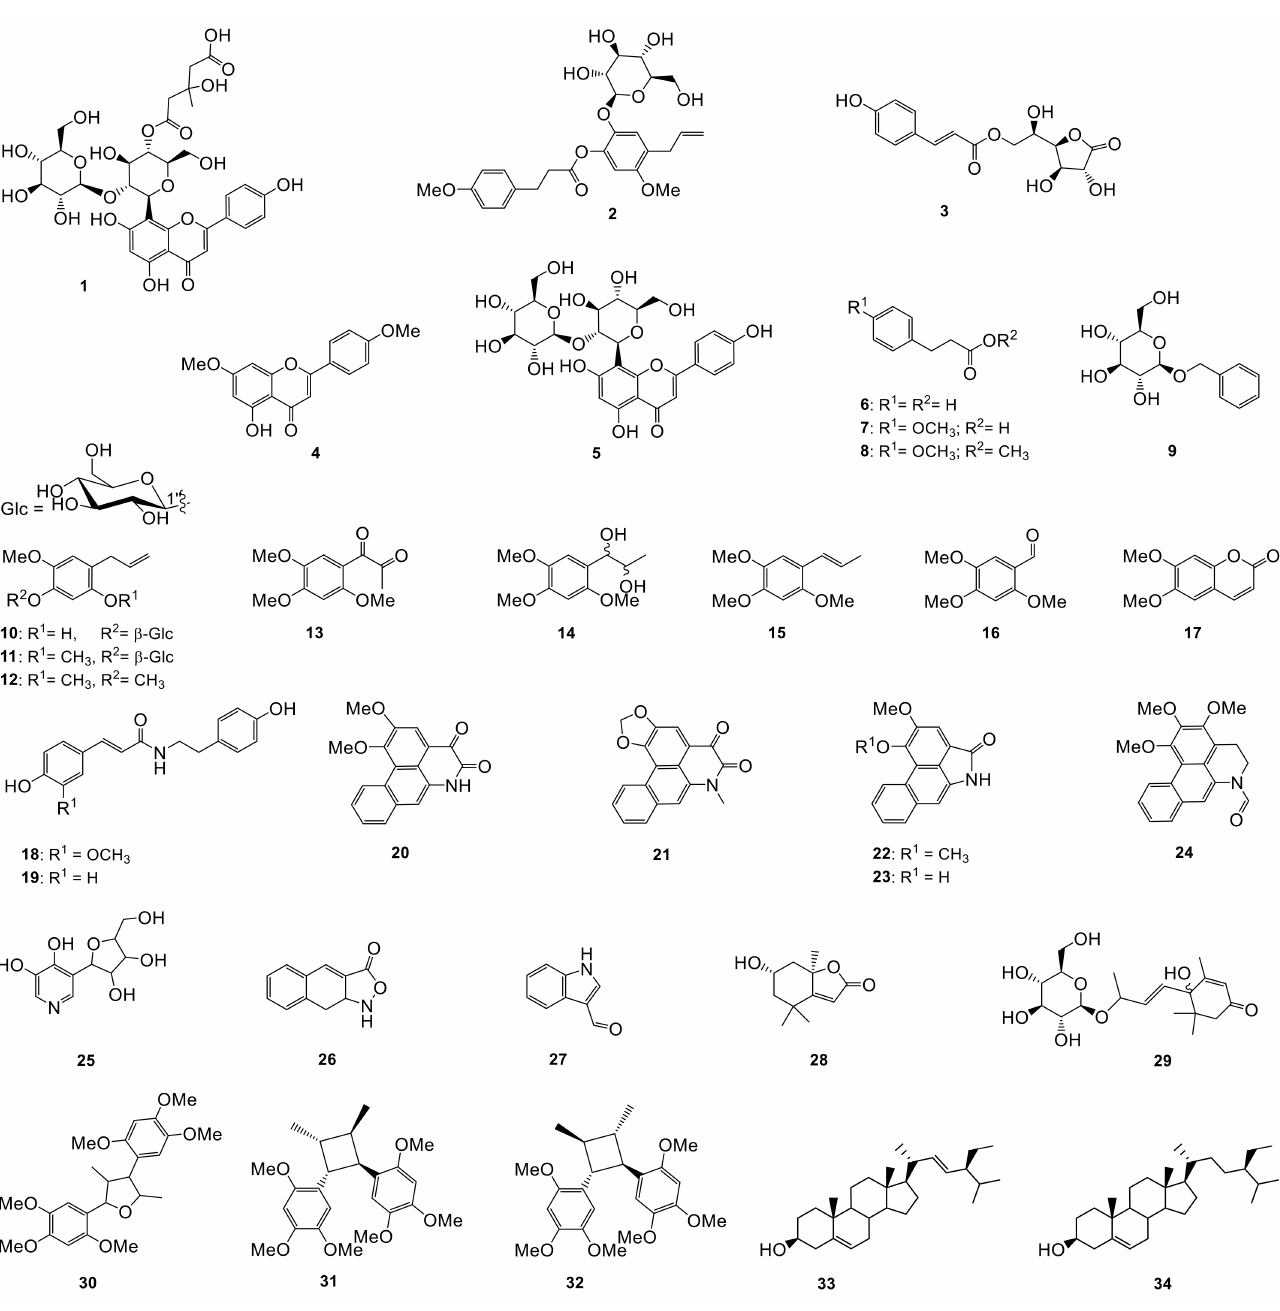
Figure 1. Chemical structures of compounds 1 – 34 . 1 H and 13 C signals of 1 were further assigned by extensive analysis of HSQC, 1 H- 1 H COSY and HMBC spectra (Figure 2, Figures S3–S6). HMBC experiments show correlation between the anomeric proton δ H 5.09 (H-1 (cid:48)(cid:48) ) and apigenin C-7/9 confirming that the disaccharide is bound by a C -glycosidic linkage at C-8. A further HMBC correlation from the anomeric proton δ H 4.26 (H-1 (cid:48)(cid:48)(cid:48)(cid:48) ) to C-2 (cid:48)(cid:48) ( δ C 80.7) revealed the interglycosidic linkage (1 → 2). The large coupling constant of the anomeric protons ( J = 10.1 Hz and H-1 (cid:48)(cid:48) -H-2 (cid:48)(cid:48) J = 7.7 Hz) determined the β –configuration of both sugar moieties. The spectral H-1 (cid:48)(cid:48)(cid:48)(cid:48) -H-2 (cid:48)(cid:48)(cid:48)(cid:48) data of 1 show similarity to those of 2 (cid:48)(cid:48) -glucosylvitexin ( 5 ) [32], with some differences at C-4 (cid:48)(cid:48) of the gly-1 unit. The downfield chemicals shift of the gly-1 methin proton (Table 1) suggests acylation of the gly-1 unit at C-4. This proton signal is correlated in the HMBC spectrum with a carboxylic carbon at δ C 172.2. The HSQC and HMBC spectra show